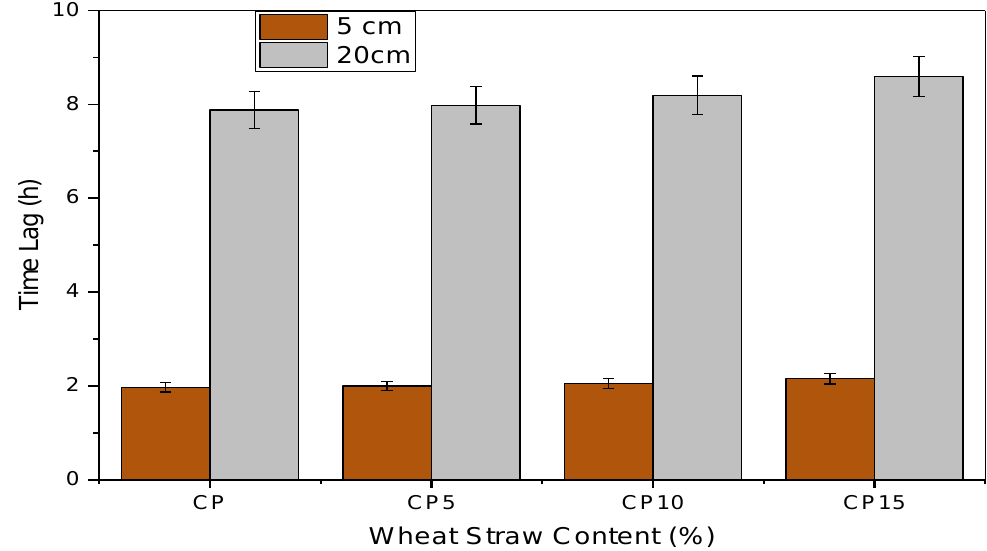
Figure 17. variation of the time lag as function of the thickness.